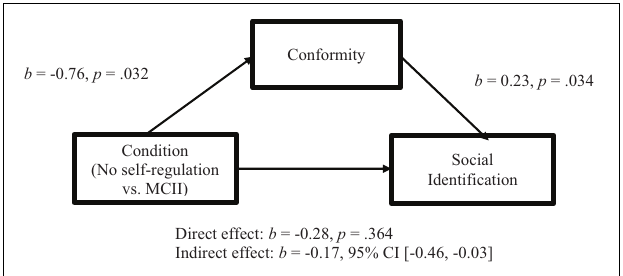
FIGURE 5 | Model of condition (No self-regulation vs. MCII) as a predictor of social identification with the group of MTurk participants, mediated by conforming behavior during the task (Study 1). The confidence interval for the indirect effect is a bootstrapped CI based on 5000